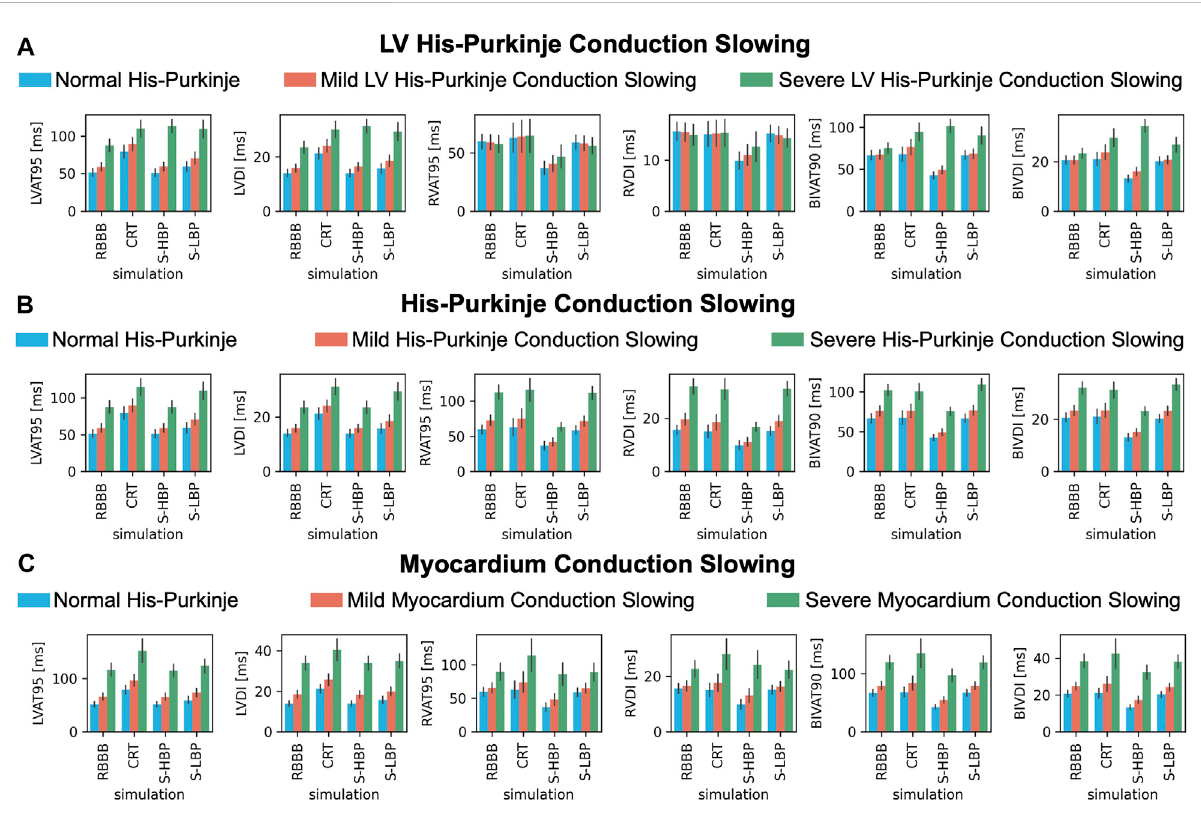
FIGURE 7 ResponsewithLVHis-Purkinje,wholeHis-Purkinjeandmyocardiumconductionslowing:LVAT-95,LVDI,RVAT-95,RVDI,BIVAT-90,andBIVDI simulated in the presence of proximal RBBB combined with otherwise normal His-Purkinje system (blue bars) and: (A) mild (orange bars) and severe (green bars) LV His-Purkinje conduction slowing; (B) mild (orange bars) and severe (green bars) His-Purkinje conduction slowing; (C) mild (orange bars) and severe (green bars) myocardium conduction slowing. Activation was simulated during baseline, standard CRT, selective HBP (S-HBP) and selective LBP (S-LBP). Results are presented as mean ± standard deviation.